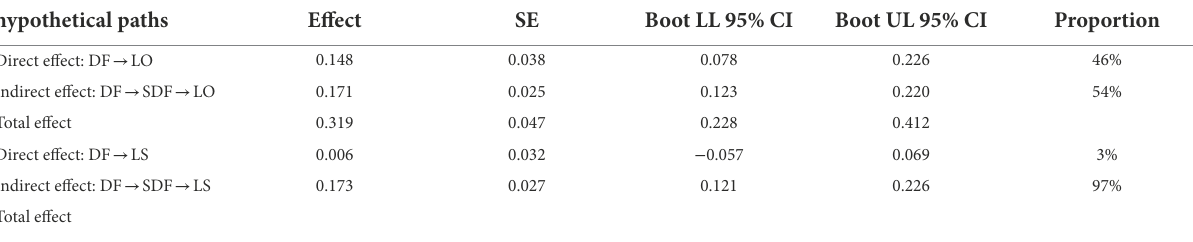
TABLE 10 Results of mediation effect test.